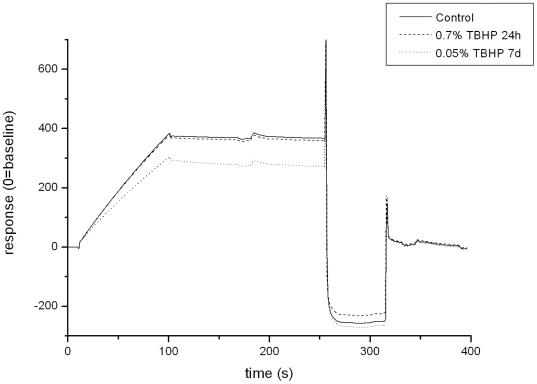
Analysis of antibody target binding by surface plasmon resonance.Biacore sensorgrams showing the pH 7.0 target binding (100 nM) following different TBHP exposures.